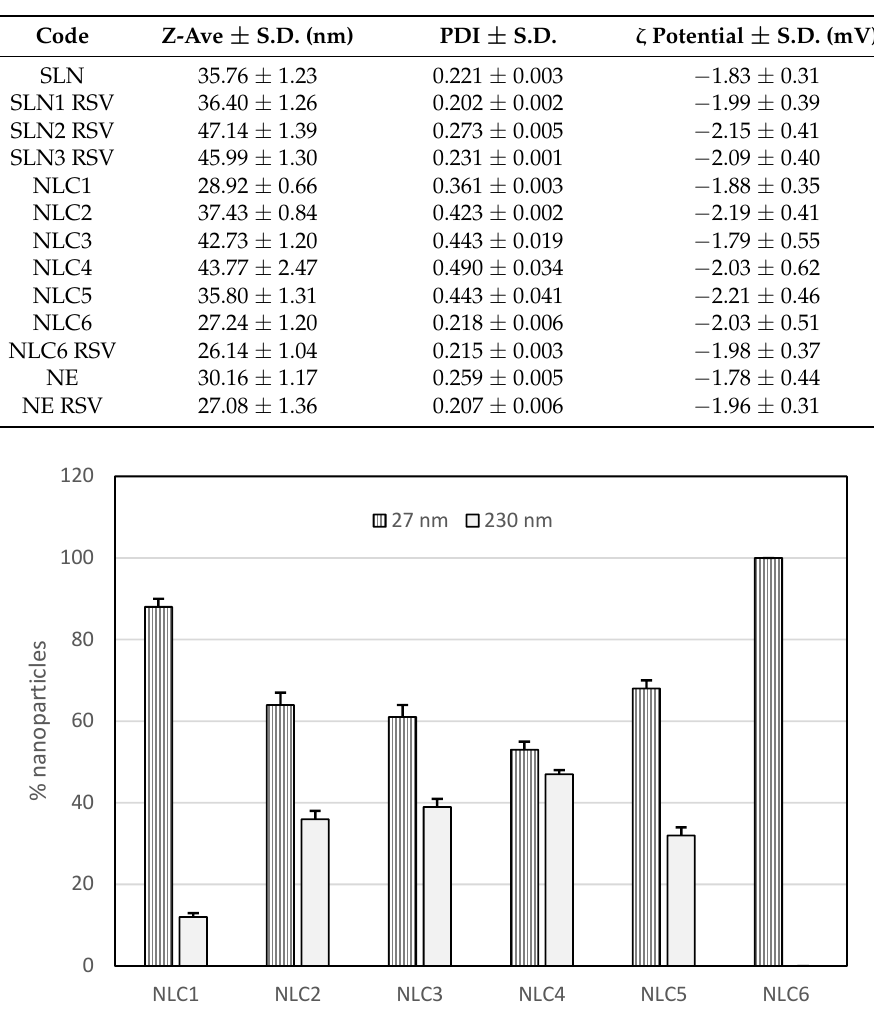
Figure 1. Percentages of nanoparticles with small size (27 nm) and large size (230 nm) in NLC1–6. Loading RSV 1% w / w in NLC6 or in NE, no significant change of particles sizes or PDI values was observed in comparison with the corresponding unloaded nanocarriers.